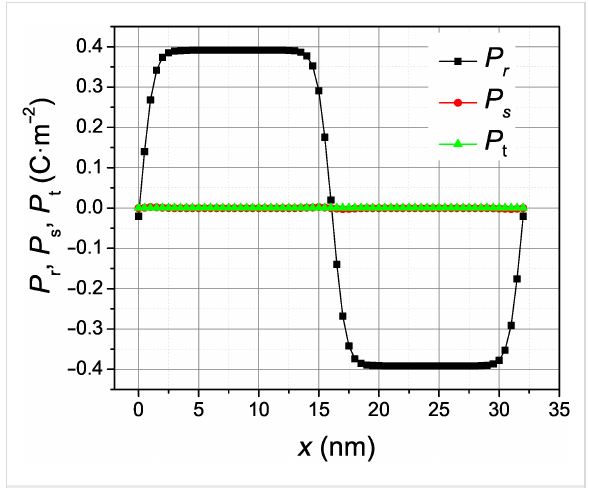
Figure 4: Relaxed profile of the polarization components across 180- degree ferroelectric wall in rhombohedral BaTiO 3 under epitaxial compressive stress of 3